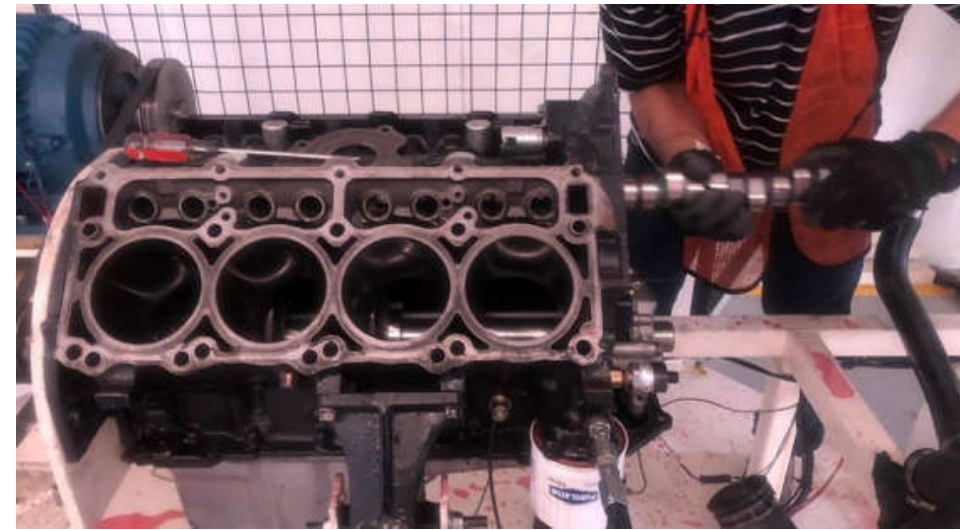
Figure 12. Removing the camshaft after complying with the test protocol.